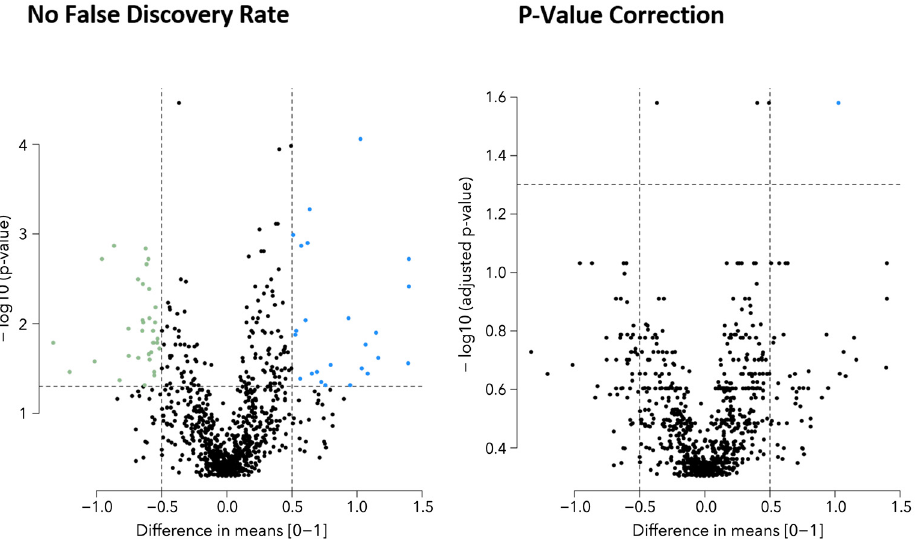
Figure A1. Volcano plots to identify microbial metabolites that significantly differed between participants with and without FIB-4 ≥ 1.45. Figure A1 displays the volcano plots that were used to determine statistically significant metabolites that had an absolute difference in means (dm)